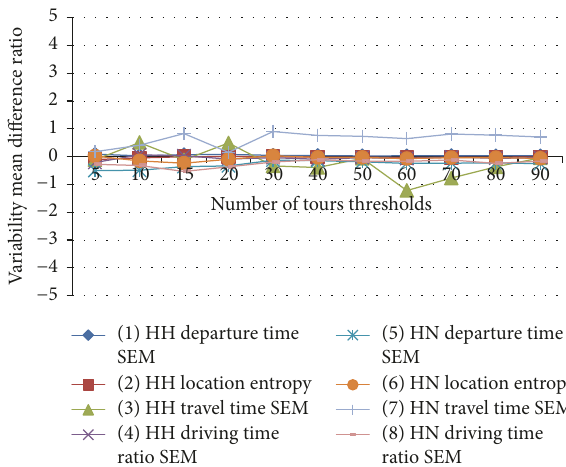
Figure 6: Variability mean difference ratio versus number of tours